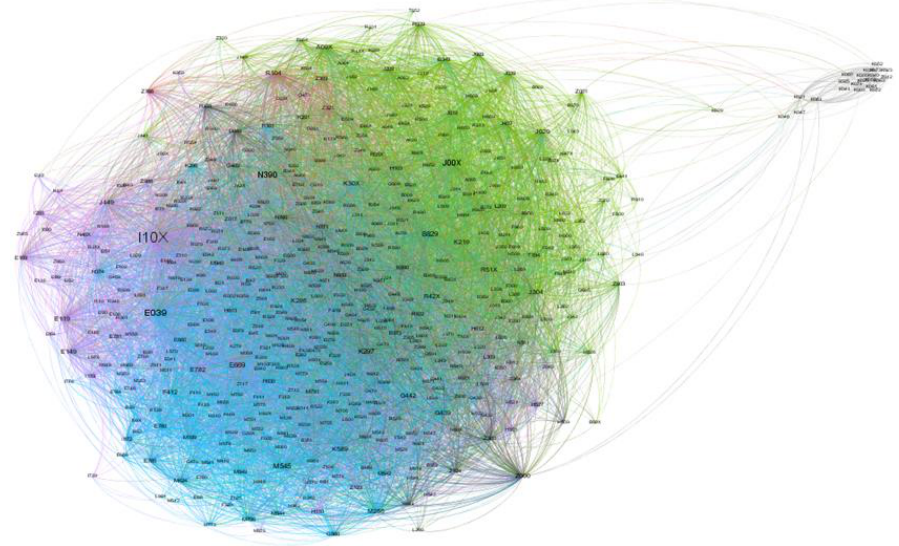
Figure 2. Graph of the Morbidity Network of Diagnoses for all medical records of residents in the Risaralda province, from 2011 to 2016. Source: authors’ own calculations.